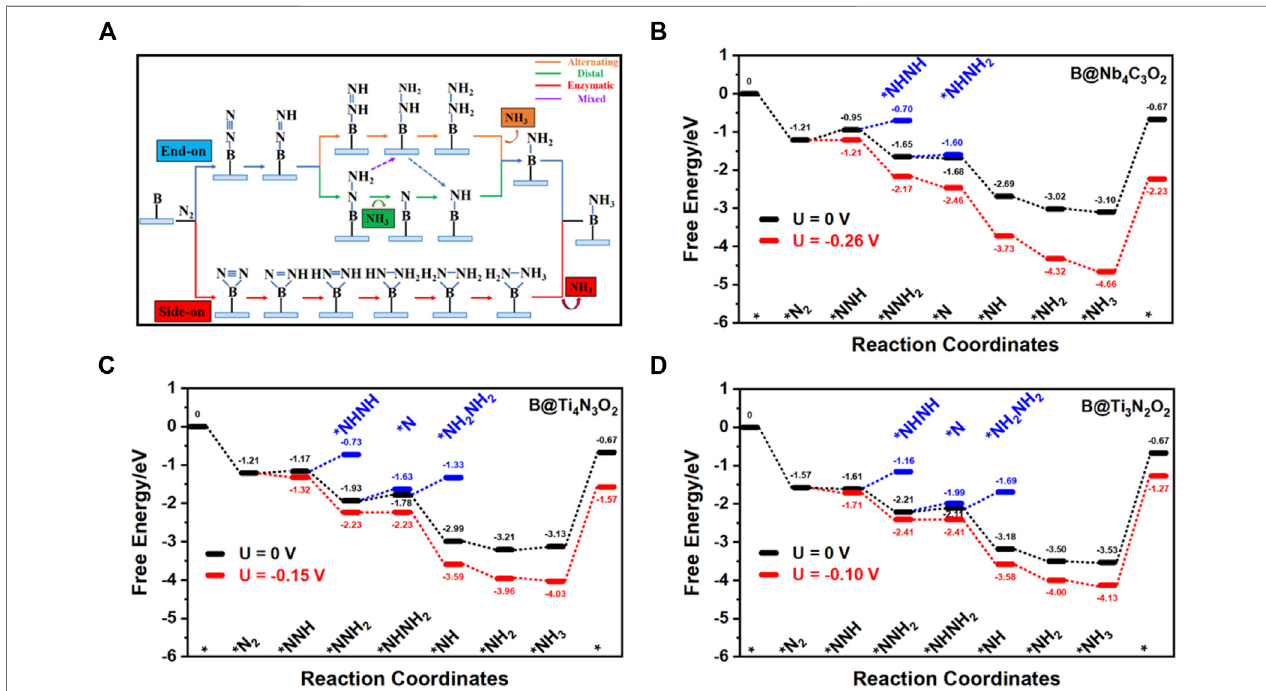
FIGURE 4 | (A) Schematic illustration of the distal, alternating, and enzymatic pathways for the electrochemical NRR. Free energy diagrams for the nitrogen reduction to ammonia on (B) B@Nb 4 C 3 O 2 , (C) B@Ti 4 N 3 O 2 , and (D) B@Ti 3 N 2 O 2 .